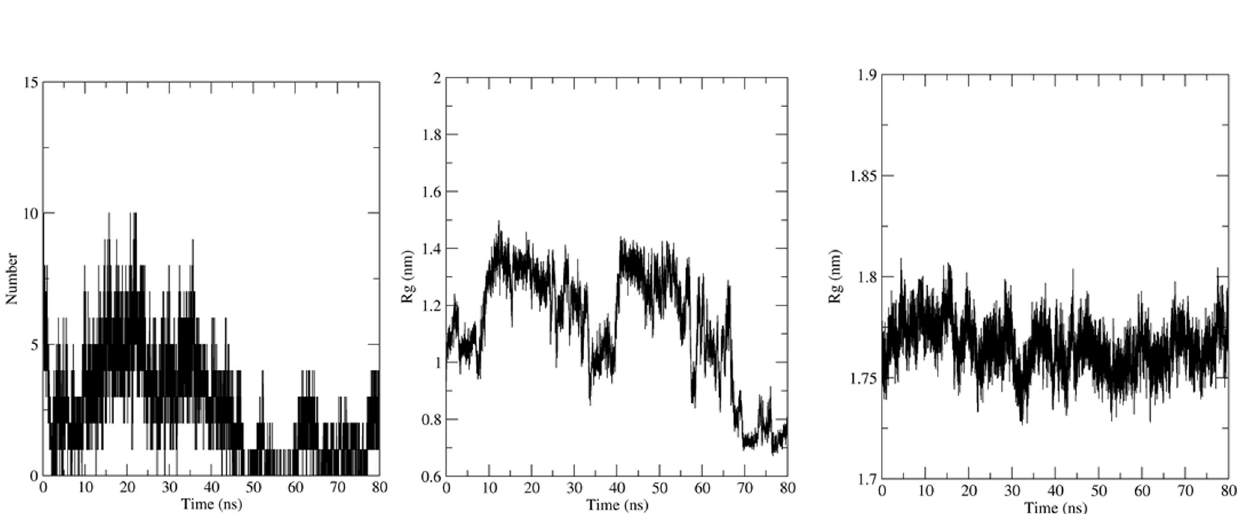
Fig 7. (a) Number of Hydrogen bonds in the MD simulation. (b) The Radius of Gyration of the components of Peptide 7 in the complex and (c) SARS-CoV in the complex.